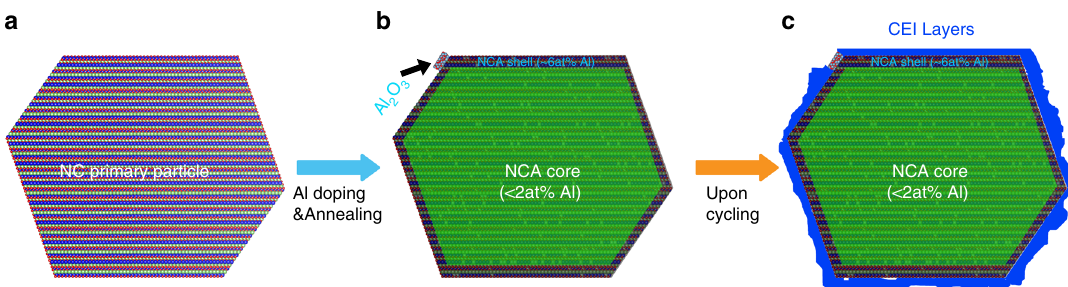
Fig. 8 Schematic drawing of Al functioning mechanism in NCA. a Pristine primary particle of NC with layered structure. b The formation of core – shell structure and the development of Al 2 O 3 nano-islands upon the high-temperature annealing during the materials synthesis stage. The green masked area indicates the core part with a Al concentration of <2 at% and the areas between the primary particle surface and green mask edge represent the shell part with a concentration of ~6 at%. The black arrow point to the Al 2 O 3 nano-islands formed on top of NCA surface. c Formation of CEI layers upon the